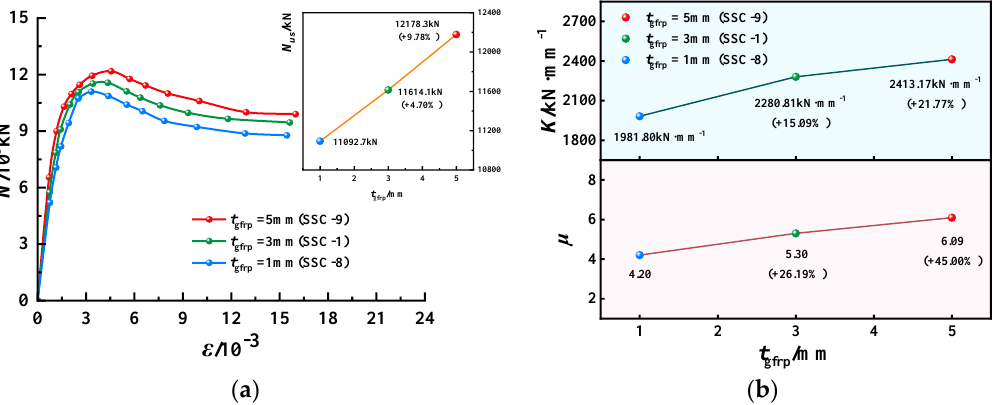
( b ) Figure 12. N - ε curves, K and µ of EGCSSCs with different t gfrp : ( a ) N - ε curves of specimens with cross-section height of 1000 mm. ( b ) K and µ of specimens with cross-section height of 1000 mm. 5.4. The Ratio of Longitudinal Reinforcement ( ρ v ) N - ε curves, K and µ of EGCSSCs with different ρ v are shown in Figures 13, 14. As seen in Figure 13, when the values of ρ v are given from 0.5% to 0.9% and 1.5%, N us of specimens with the cross-section height of 800 mm could be increased from 114,985.0 to 11,614.1 kN firstly, and then N us kept unchanged. K could be increased from 2257.97 to 2280.81 kN·mm −1 firstly, and then K kept unchanged. µ was 5.30 and kept unchanged. It can be seen in Figure 14, when the values of ρ v are given from 0.5% to 0.9% and 1.5%, N us of specimens with the cross-section height of 1000 mm could be increased from 1709.4 to 17,180.0 kN firstly, and then kept unchanged. K could be increased from 2044.04 to 2046.14 kN·mm −1 firstly, and then K kept unchanged. µ was 5.66 and kept unchanged. It was summarized that the change in ρ v had little effect on the axial compression perfor- mance of the EGCSSCs.